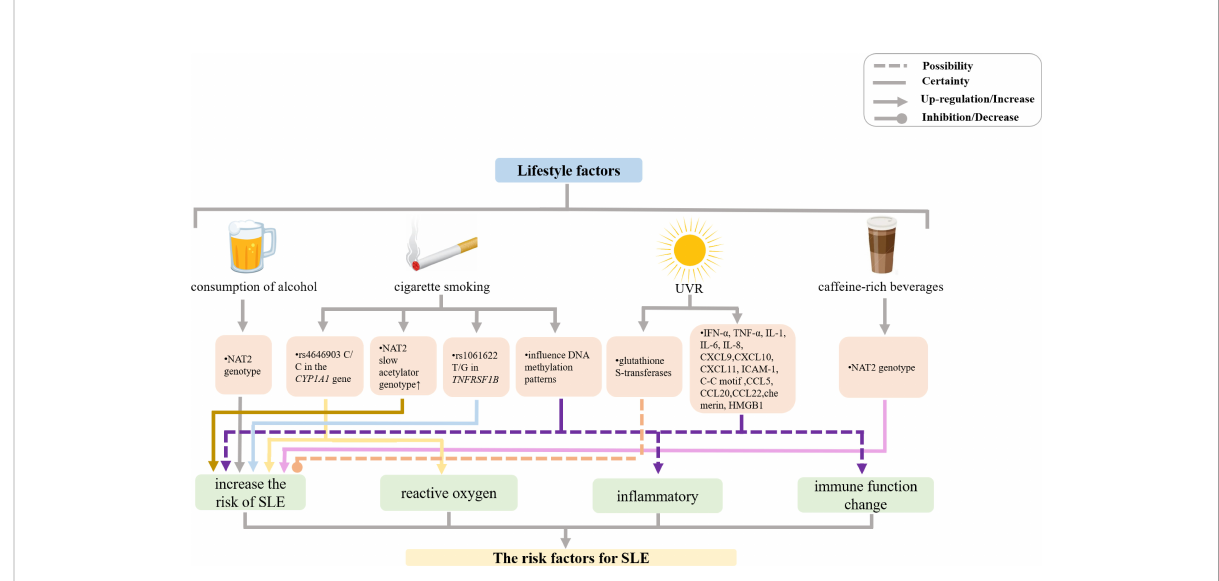
FIGURE 2 Mechanisms of other lifestyle factors effects on SLE incidence and manifestations. (UVR, ultraviolet radiation; NAT, N-acetyltransferase; IFN, interferon; TNF, tumor necrosis factor; IL, interleukin; CXCL, chemokine (C-X-C motif) ligand; CCL, chemokine (C-C motif) ligand; ICAM, intercellular adhesion molecule; HMG, high-mobility group